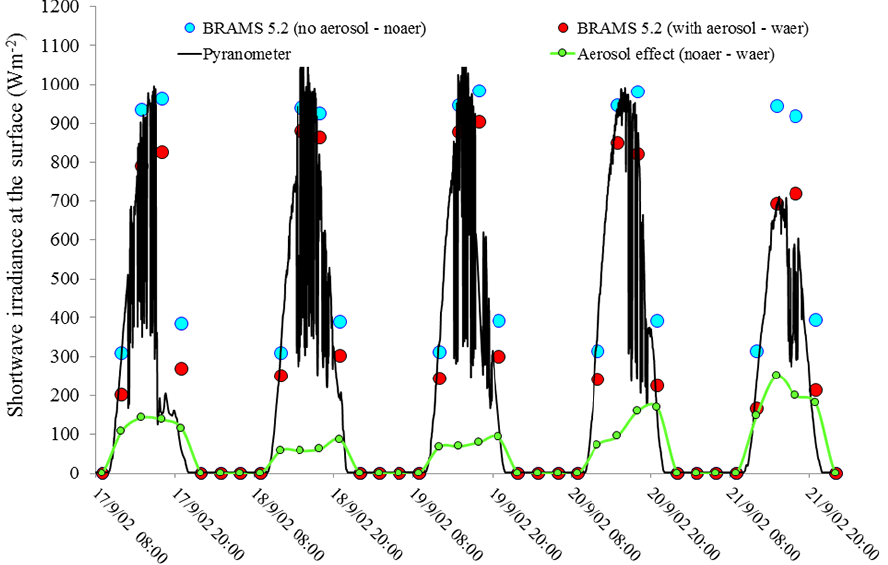
Figure 2. Time series of downwelling shortwave irradiance (Wm − 2 ) at the Abracos Hill AERONET site during a cloudy period from 17 to 21 September 2002 from BRAMS 5.2 results with (in red) and without (in blue) aerosol effects. The black line refers to measurement data in the same periods, and the green (line and marks) is the attenuation due to the aerosol effect.